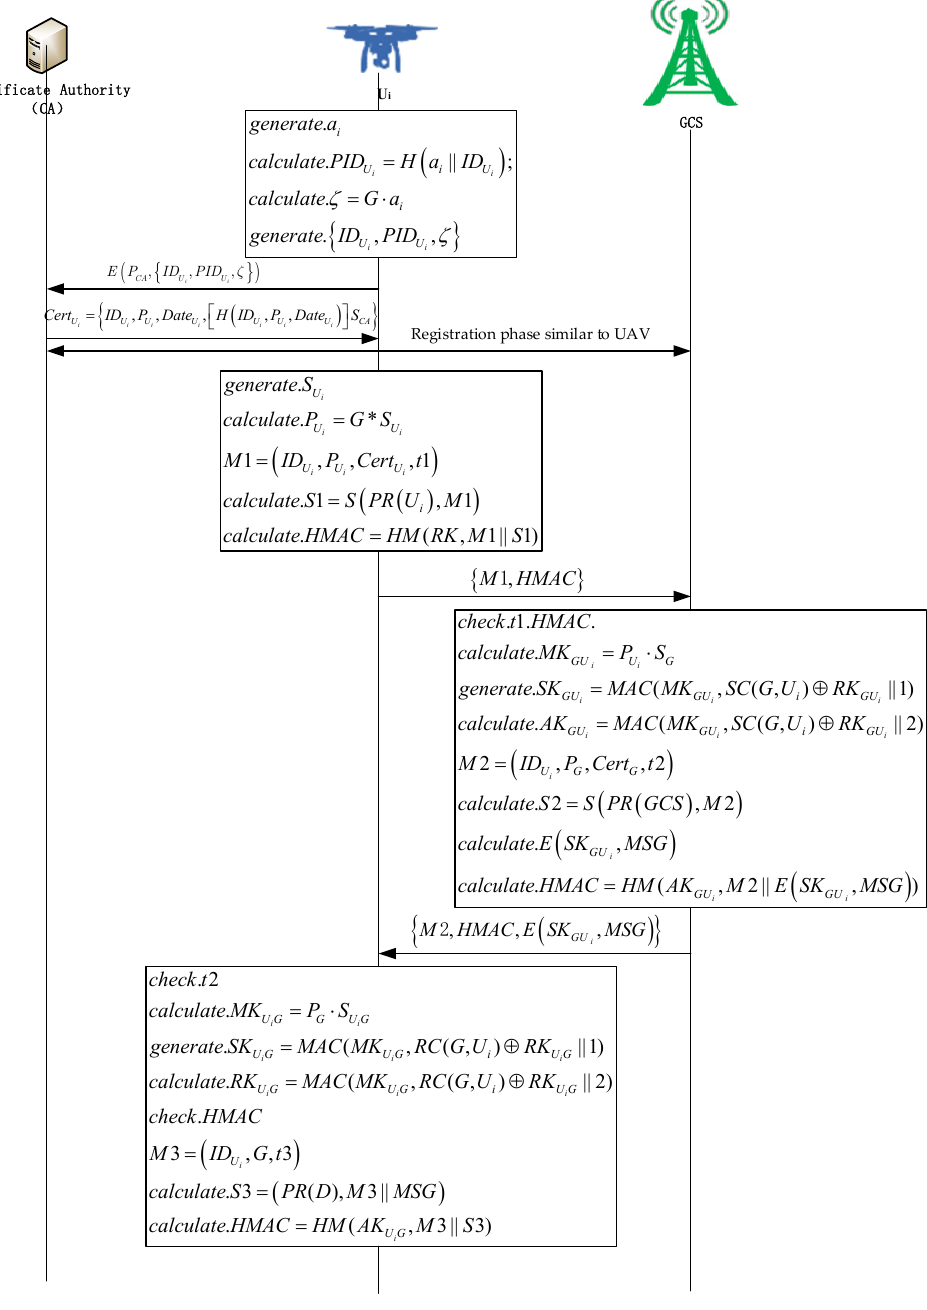
Figure 2. Authentication process of the proposed protocol.